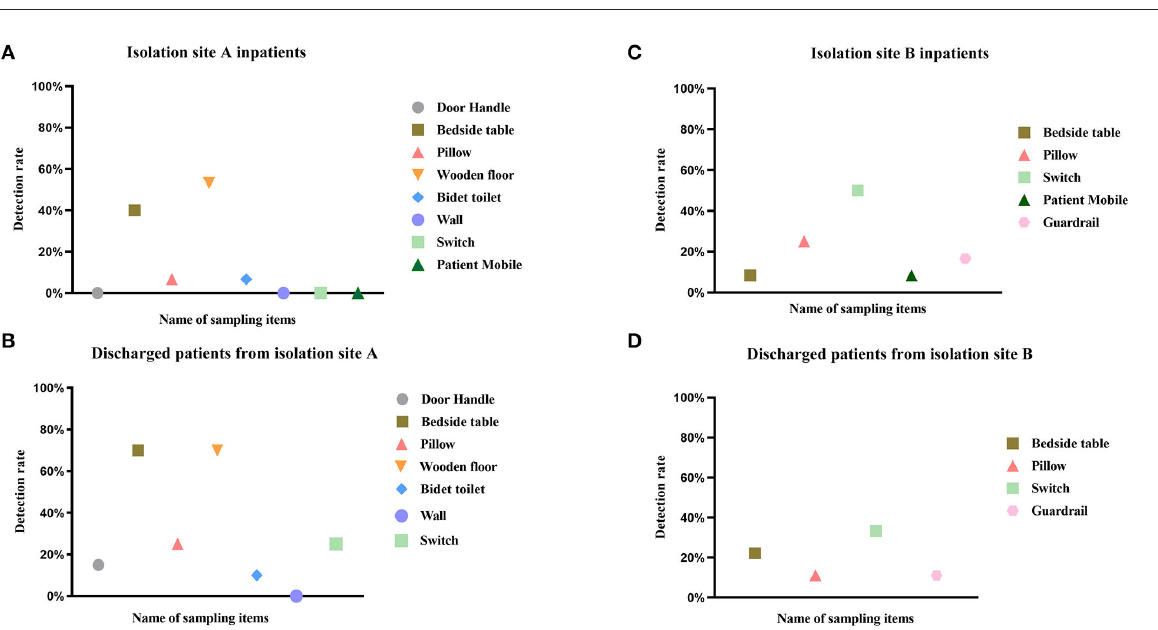
0.413), although there were differences in their